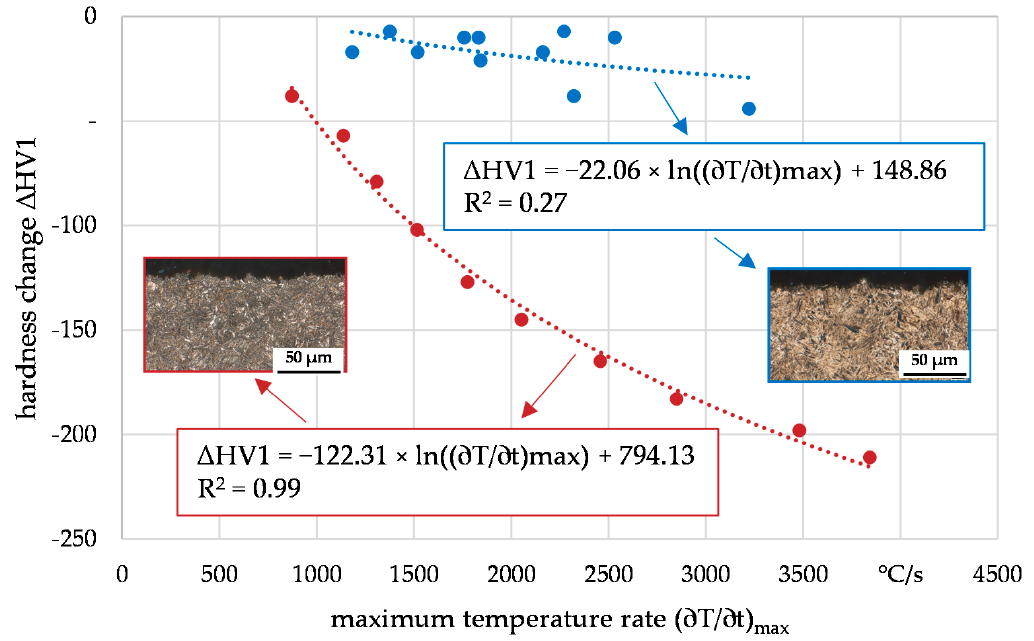
Figure 12. Hardness change dependent on the maximum temperature rate in consideration of metallographic cross-section analysis (blue: no visible heat-affected zone; red: visible heat-affected zone).